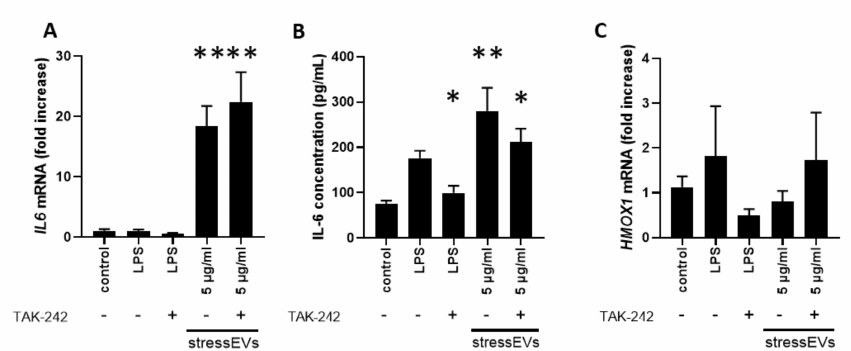
Figure 4. StressEVs activate interleukin signaling in AC16 cells. AC16 cells were stimulated for 6 h with stressEVs (5 µ g / mL) or LPS (10 ng / mL) in the absence or presence of TAK-242 (2.5 µ M). IL6 and HMOX1 mRNA levels were determined by qPCR ( A , C ) ( n = 6; ** p < 0.01 vs. control), and IL-6 expression was detected using ELISA ( B ) ( n = 3; ** p < 0.01 vs. control; * p < 0.05 vs. control).